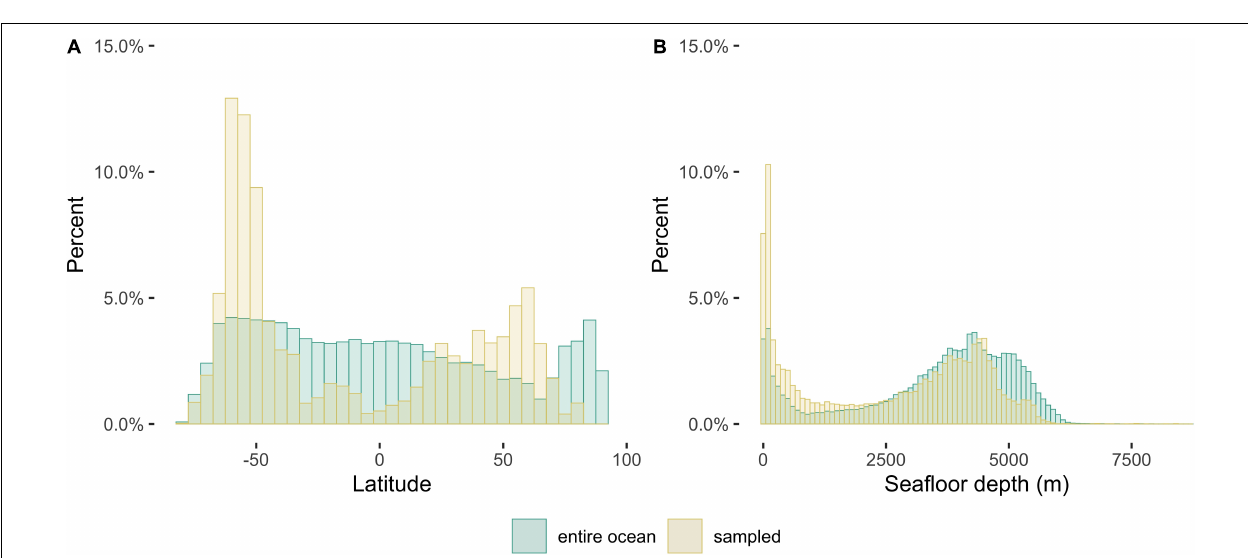
FIGURE 2 | Spatial coverage of known active, long-term biological observations globally (colored regions). Color indicates biological observations identified from the survey only (blue- 5% of ocean surface), from datasets in the Ocean Biodiversity Information System (OBIS) and the Global Biodiversity Information System (GBIF) only (teal- 1% of ocean surface), and those identified in both sources (green- 1% of ocean surface; map displayed across ≥ 0.5 ◦ grid cell: about 55 km 2 at the equator). Gray lines show Exclusive Economic Zones (EEZ; 200 nm) of nations with no known biological Essential Ocean Variable (EOV) sampling according to this study.